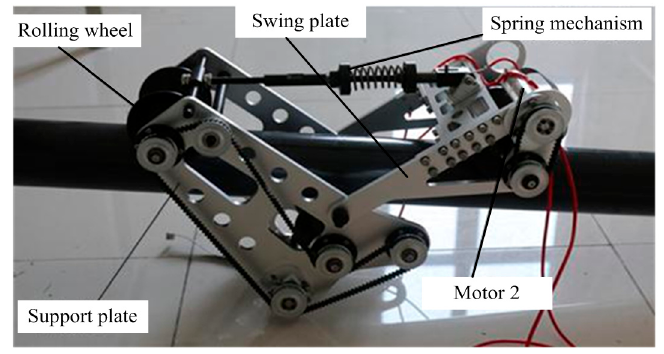
Figure 13. Three-wheel climbing robot.